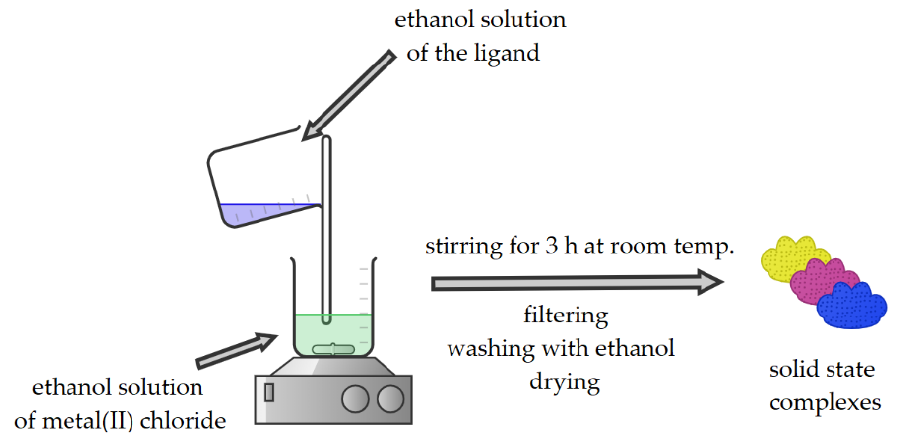
Figure 1. Synthesis of the investigated complexes.